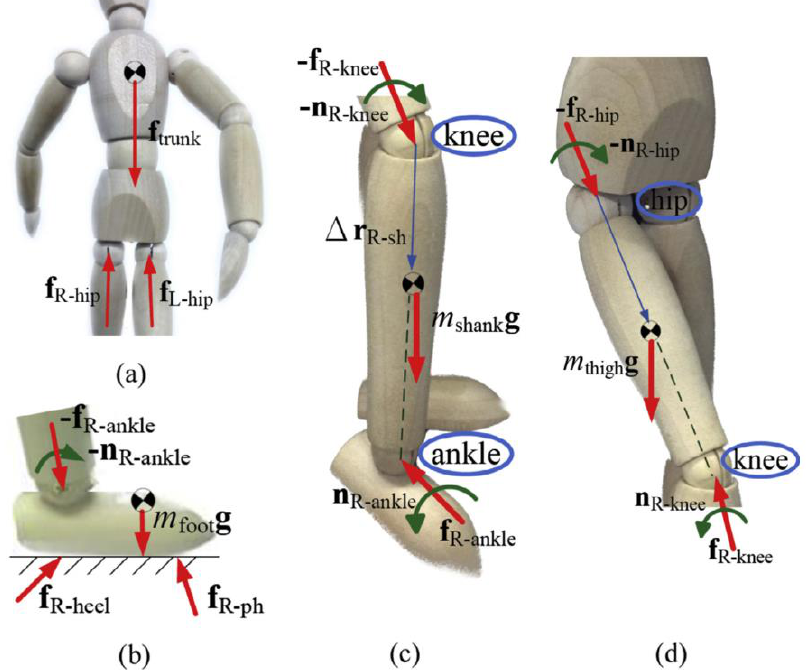
Figure 5. Biomechanical model as defined by [44] and the respective free body diagrams of: ( a ) trunk, ( b ) foot, ( c ) lower leg, ( d ) upper leg.